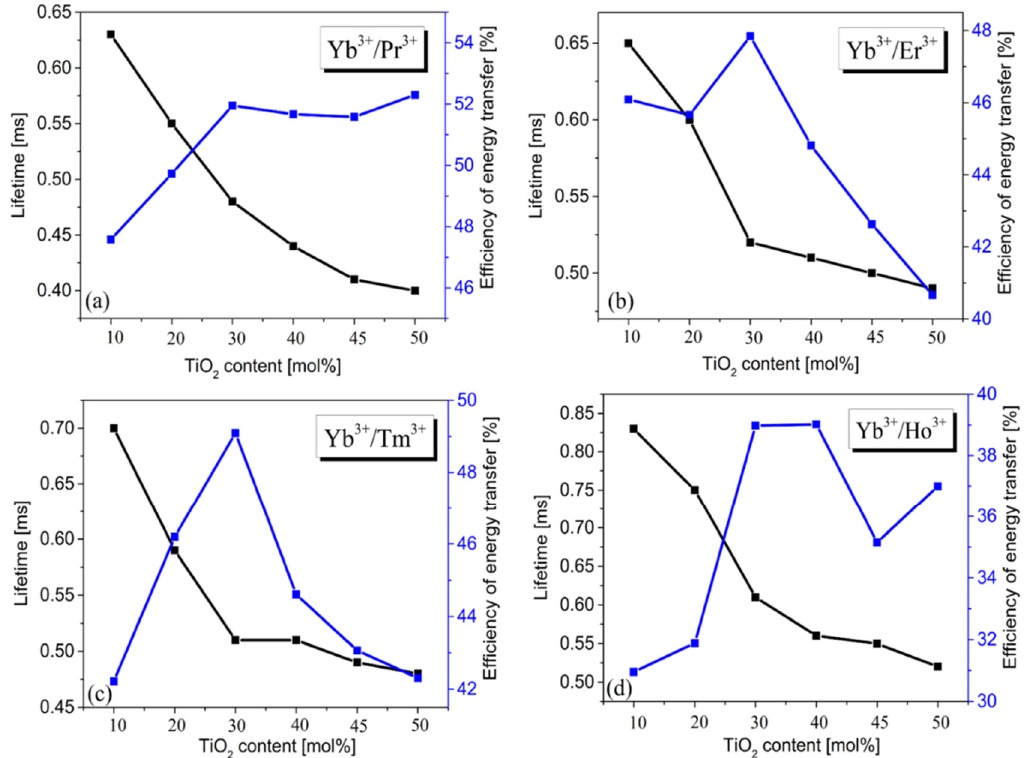
Figure 8. The measured luminescence lifetime and the energy transfer efficiency Yb 3+ → Ln 3+ (where Ln = Pr ( a ), Er ( b ), Tm ( c ), Ho ( d ) in the function of TiO 2 content. Our studies indicate that measured lifetimes decrease with increasing TiO 2 content, while changes in the energy transfer efficiency seems to be completely different. For all pairs of Yb 3+ /Ln 3+ (Ln = Pr, Er, Tm, Ho), the energy transfer efficiency is the highest for the 1Ge ‐ 1Ti system, but the trend of η ET values varying with TiO 2 content is not the same. For the pair of Yb 3+ /Pr 3+ , the values of η ET increase to 1Ge ‐ 1Ti, whereas they are nearly inde ‐ pendent for glasses with higher TiO 2 content. For pairs Yb 3+ /Er 3+ and Yb 3+ /Tm 3+ , the energy transfer efficiency increases from 5Ge ‐ 1Ti to 1Ge ‐ 1Ti and then decreases to 1Ge ‐ 5Ti with further increasing TiO 2 concentration. For the pair of Yb 3+ /Ho 3+ , the values of η ET are the highest for 1Ge ‐ 1Ti to 1Ge ‐ 2Ti glass systems, respectively; however, the changes of η ET with TiO 2 content are non ‐ linear. Our calculations indicate that the energy transfer effi ‐ ciencies are changed from 31% for Yb 3+ /Ho 3+ glass (5Ge ‐ 1Ti) to nearly 53% for Yb 3+ /Pr 3+ glass (1Ge ‐ 5Ti). At this moment, it should also be mentioned that the up ‐ conversion lumi ‐ nescence pathways [60] make an important contribution to the energy transfer processes and their efficiencies in Yb 3+ /Ln 3+ (Ln = Pr, Er, Ho, Tm) co ‐ doped glasses.